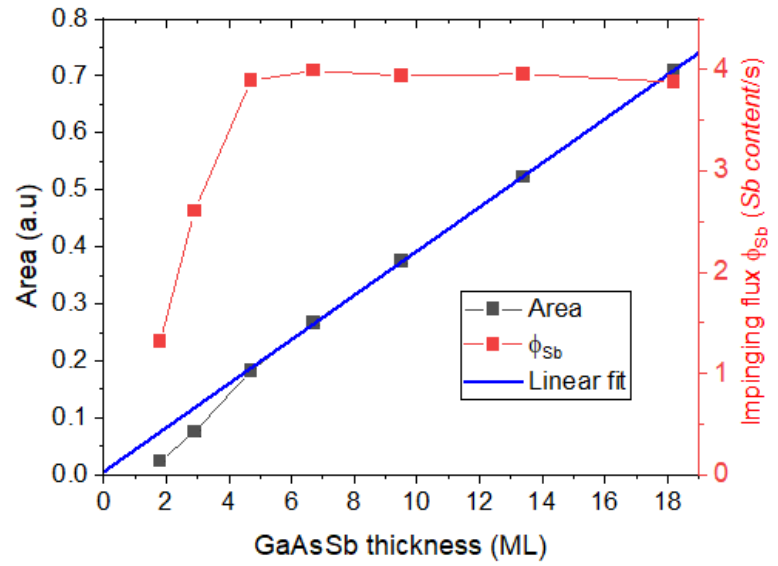
Figure 6. Area under the Sb profiles along the growth direction (left) and the relative impinging Sb flux calculated from every Sb profile (right). Stabilization of growth conditions is only achieved in layers thicker than 5 MLs of GaAsSb.